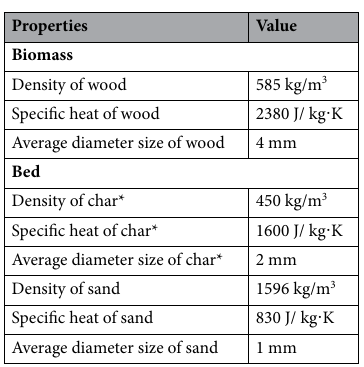
Table 5. Physical properties of solids used in the simulations. *Char was active bed used only for validation with the experiment of Gerber et al. 30